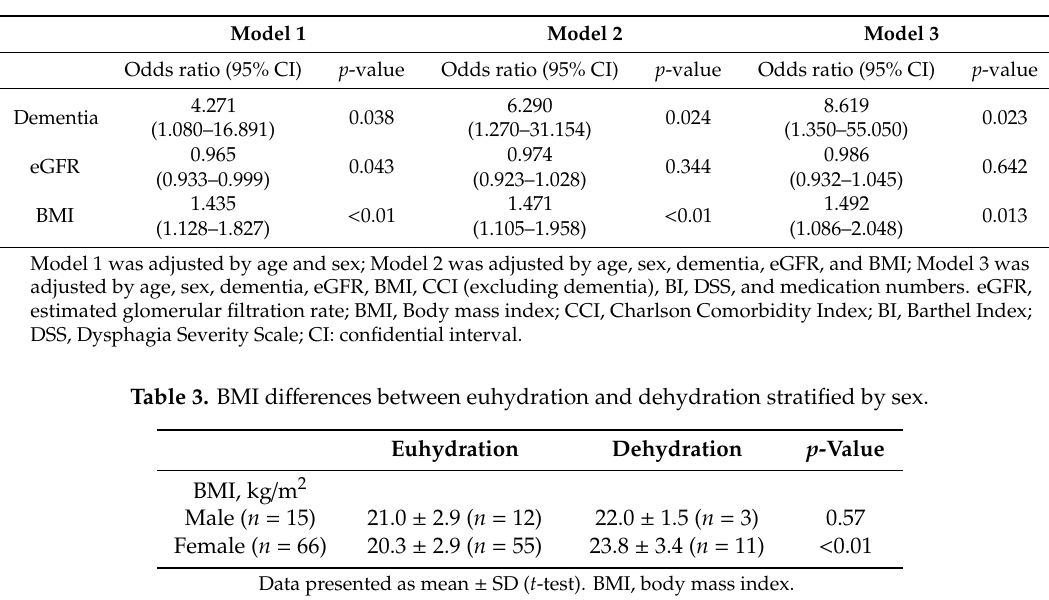
Table 2. Factors associated with chronic dehydration in multivariate logistic regression analysis.